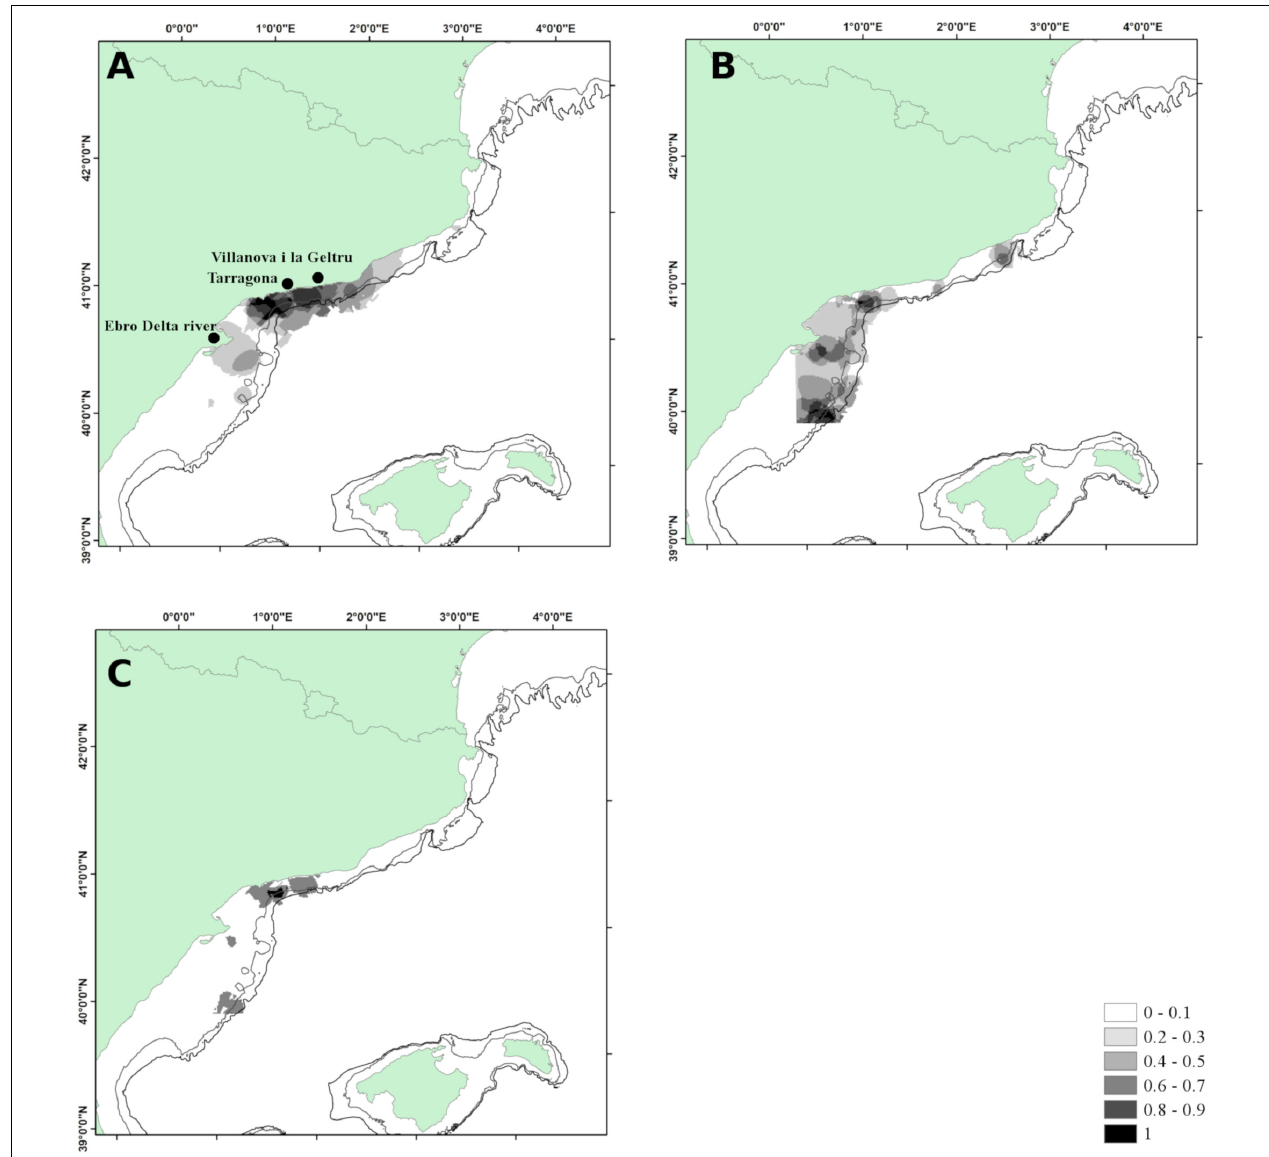
FIGURE 3 | Area 1 – Catalan Sea. (A) Persistence index of Trachurus spp.; (B) persistence index of Merluccius merluccius ; (C) interspecific persistence index (IPI). Depth contours shown are 100 and 200